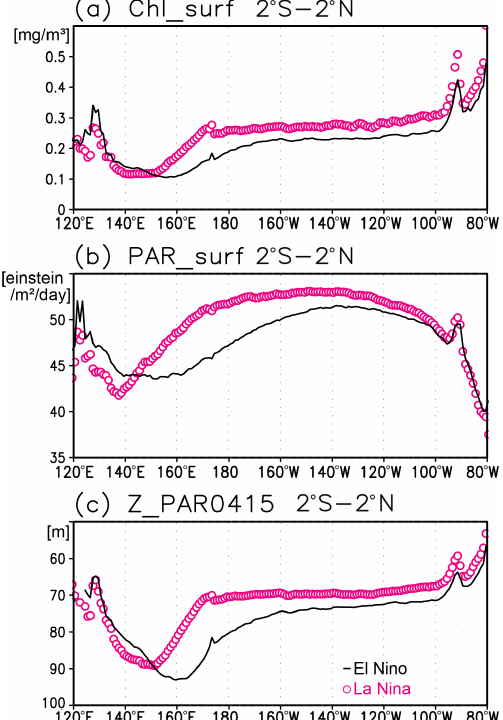
Figure 12. (a) Satellite-derived surface chlorophyll a concentra- tions, (b) surface photosynthetically available radiation (PAR), and (c) the photosynthetically active layer ( > 0 . 415molm − 2 d − 1 of PAR) along the equatorial Pacific during El Niño (solid black lines) and La Niña (open magenta